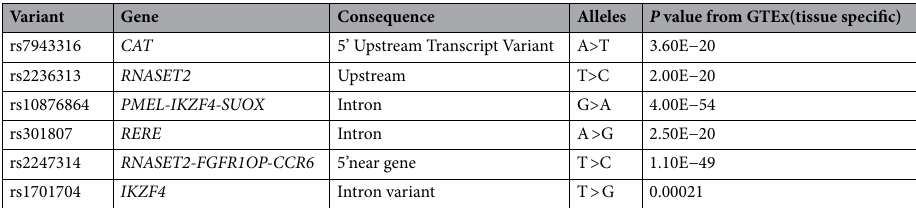
Table 3. List of the prioritized vitiligo associated non-coding SNVs.